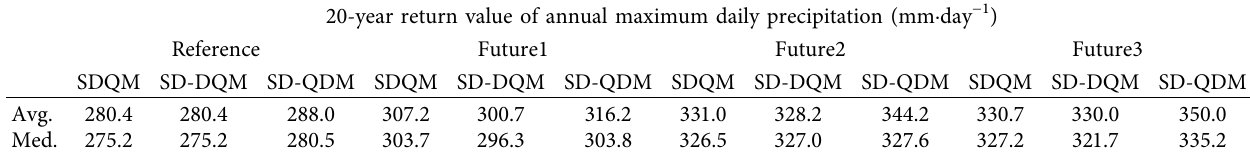
Figure 3: Average of 20-year return value of annual maximum daily precipitation for CMIP5 26 GCMs by SDQM ((a), (b), and (c)), SD- DQM ((d), (e), and (f)) and SD-QDM ((g), (h), and (i)) for the reference ((a), (d), and (g)), Future3 period ((b), (e), and (h)), and the difference between reference and Future3 period in percentage ((c), (f), and (i)). Table 2: Average of 20-year precipitation under reference, Future1, Future2, and Future3 period for South